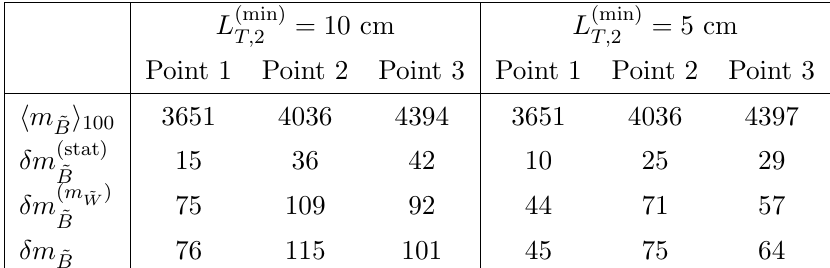
and (cid:14)m ( m ~ W ) in ~ B ~ B